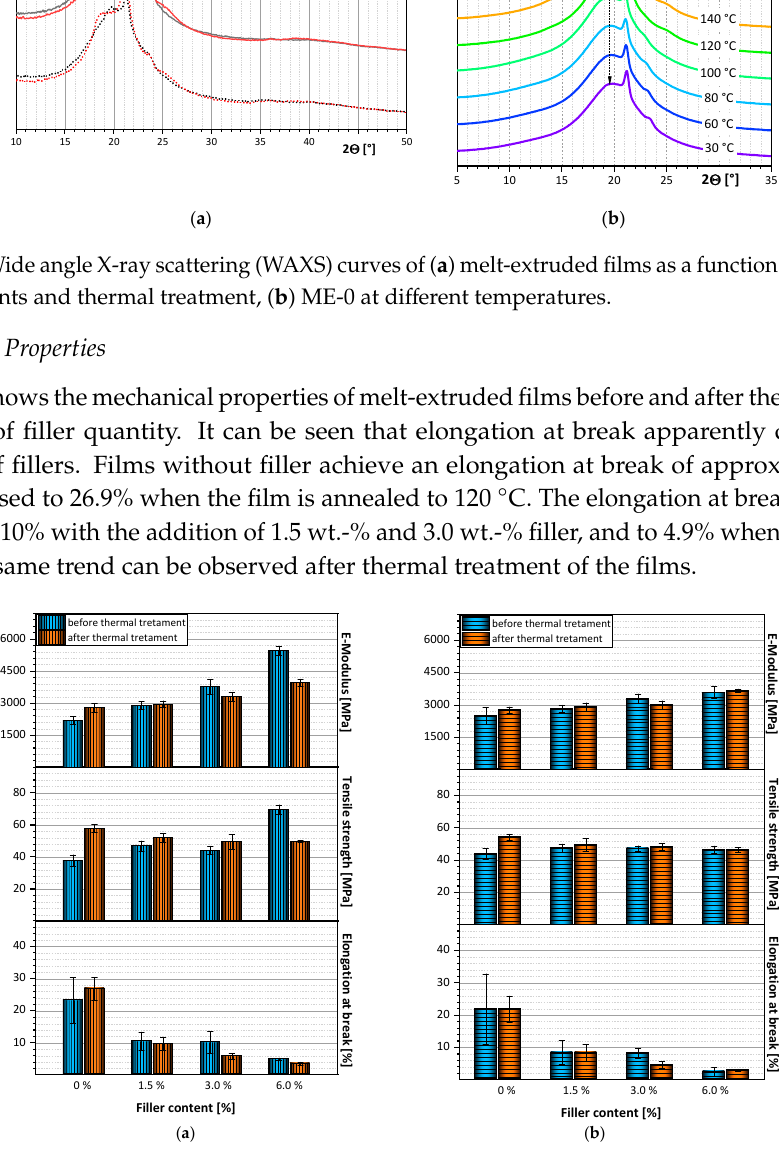
Figure 7. Optical microscopy (OM) images of extruded films ME-0 ( a ) before thermal treatment and ( b ) after thermal treatment.